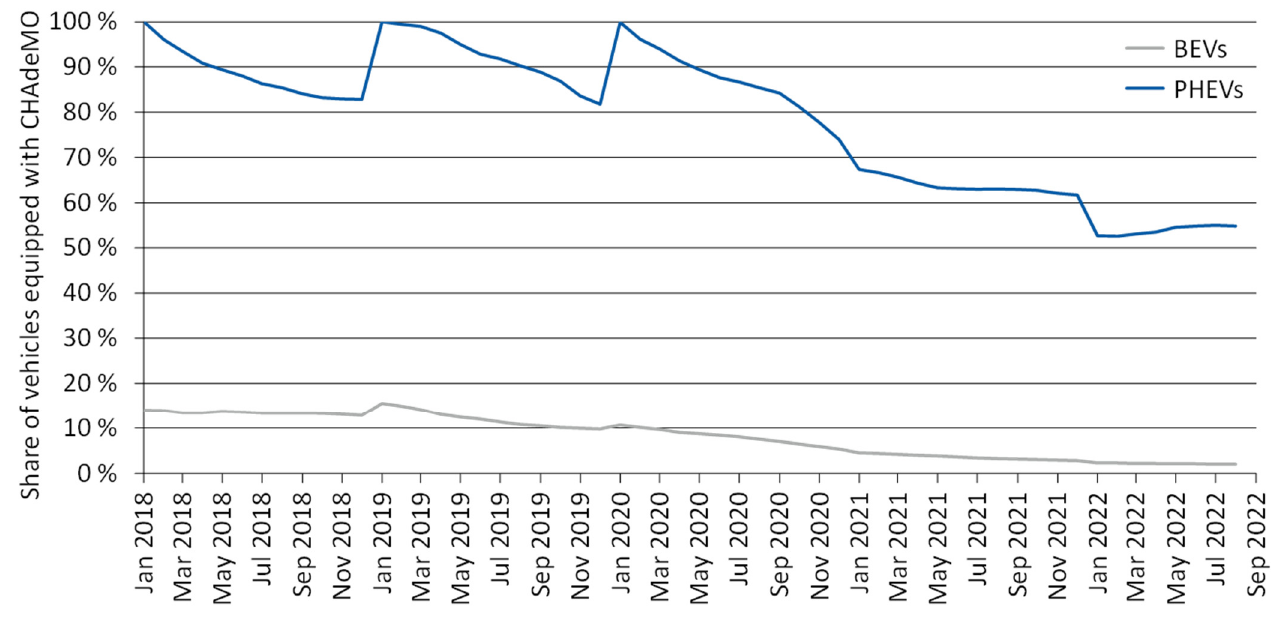
Figure 6. Share of vehicles with fast-charging connectors that are equipped with CHAdeMO compared to the overall number of vehicles with fast chargers installed. Note that the low number of PHEVs with fast-charging connectors leads to some fluctuation, particularly in the early years.